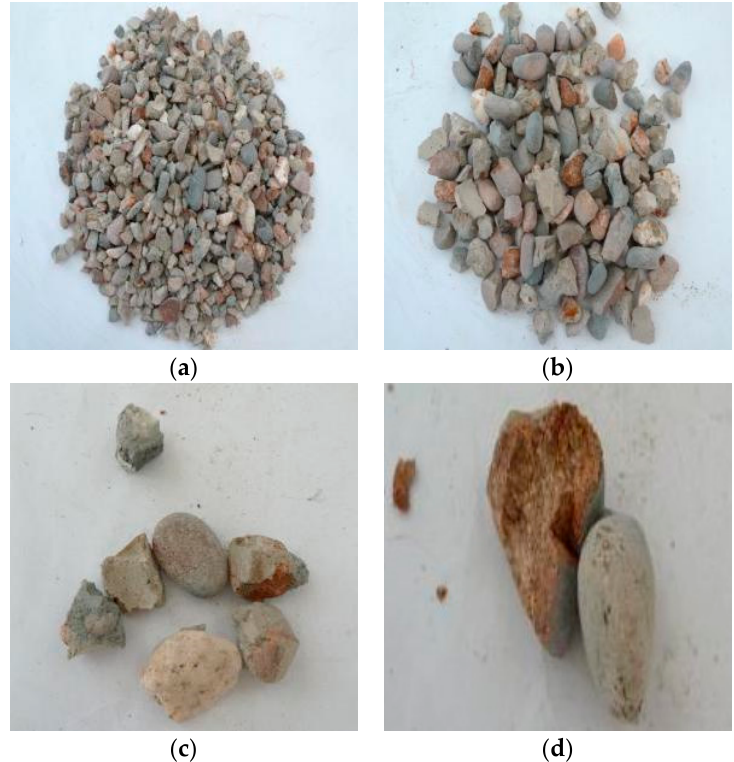
Figure 7. Concrete particles after slow heating up to 600 °C and sieving (impact speed 8.6 m/s), water cooling. ( a ) 5 mm (47.02%); ( b ) 10 mm (23.93%); ( c ) 16 mm (7.44%); ( d ) 20 mm (21.54%).